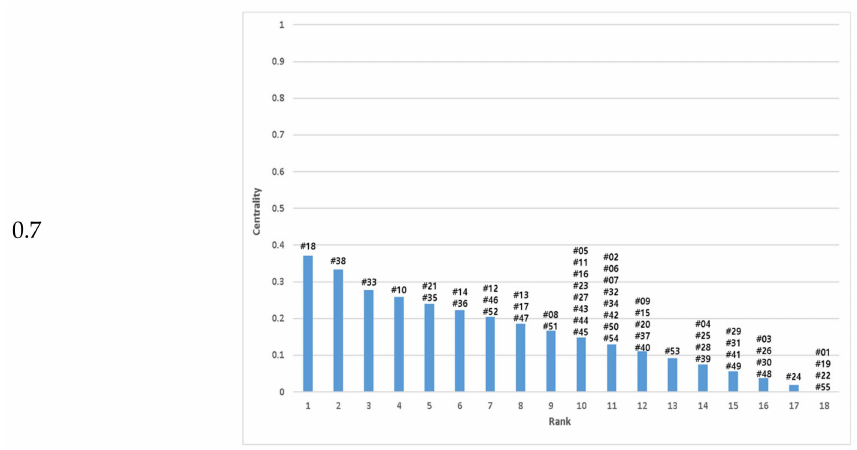
Figure 8. Estimation of centrality and rank of station by mutual information: on the X -axis is the rank of station and on the Y -axis are the values of centrality. The number upon the bar mean the stations which belong to the rank.